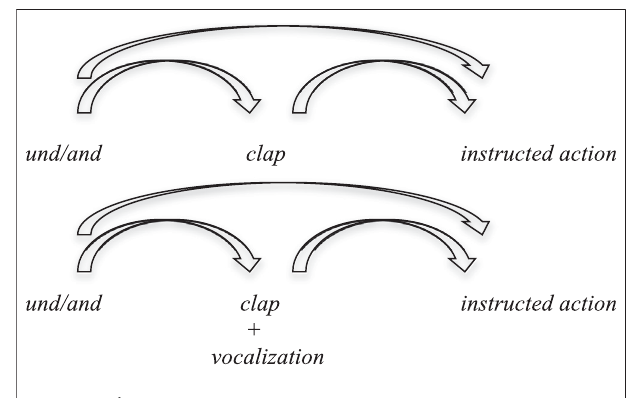
FIGURE 9 | Projection of timing